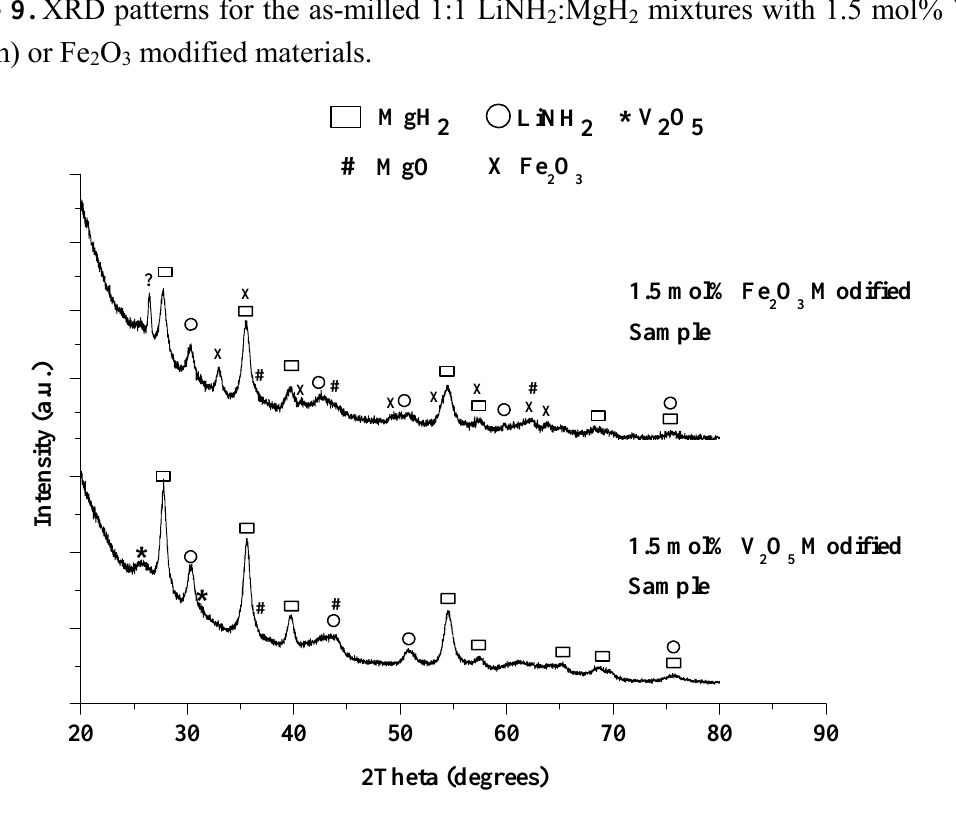
:MgH mixtures with 1.5 mol% V 2 2